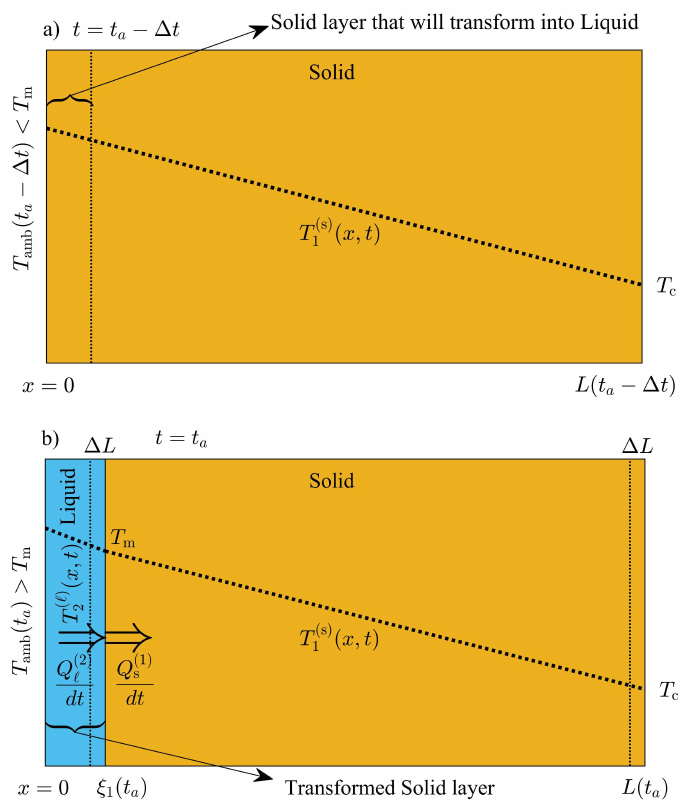
Figure 4. Liquid phase formation close to the exterior surface produced by the change of the ambient temperature from T amb ( t a − ∆ t ) < T m to T amb ( t a ) > T m during a small time interval ∆ t . ( a ) Thin solid layer that will melt close to the exterior surface. The layer is still in its solid form at t = t a − ∆ t , when the temperature on the exterior surface is just below T m . ( b ) Volume expansion ∆ L = L ( t ∆ t ) after the formation of the liquid layer. The exterior surface is pushed a ) − L ( t a − rightwards, due to the expansion of the solid layer after the transition to its liquid